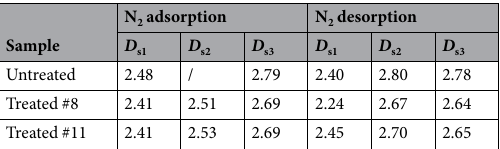
Table 3. Fractal parameters for untreated and bioconverted coals.